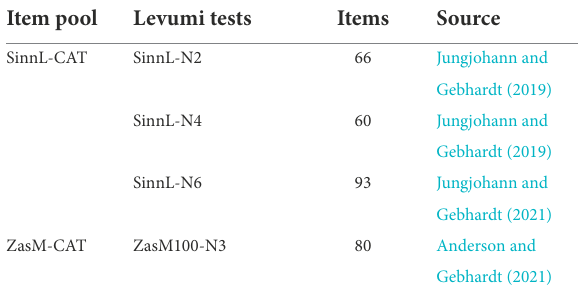
TABLE 1 Overview of used tests and number of items for the sentence reading CAT (SinnL-CAT) and addition and subtraction CAT (ZasM-